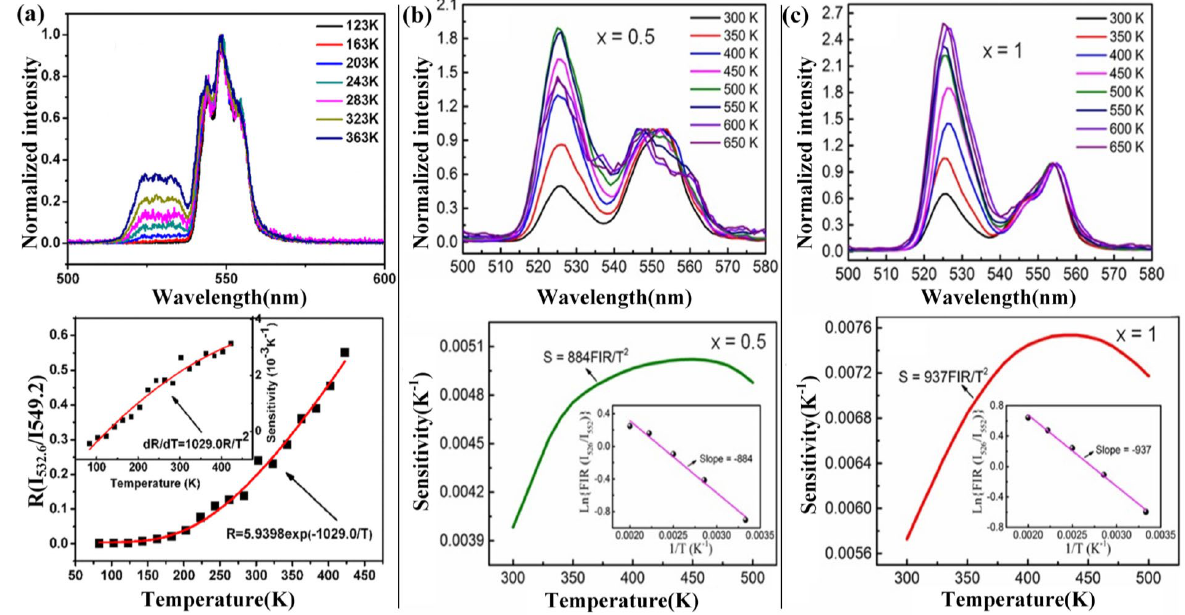
Figure 7. ( a ) The UC emission spectrum normalized by BTW-0.05 at 123 K, 163 K, 203 K, 243 K, 283 K, and 323 K and the FIR (R (I 532.6 /I 549.2 )) emitted by green UC at 83 K~423 K are shown as a function of absolute temperature. The inset shows the temperature dependence of sensitivity. Reprinted with permission from [50] © 2017 AIP. ( b , c ) is the sensitive pair of the UC green emission of KNNLB-Ho-x (x = 0.5, 1) sample in the range of 300 K – 500 K and the temperature sensor of KNNLB-Ho-x, in which the inset shows the log normal diagram of fir and reverse absolute temperature. Reprinted with permission from [51] © 2018 American Ceramic Society.